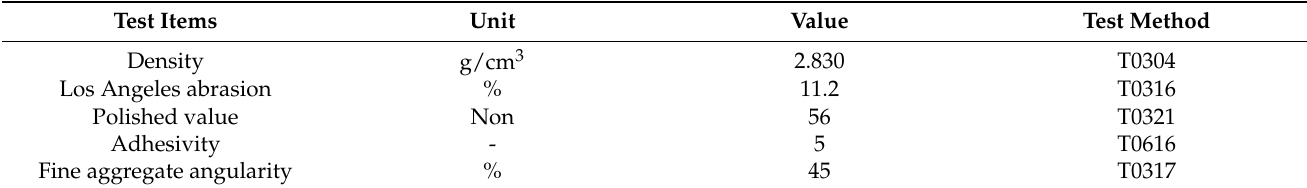
Table 2. Technical properties of aggregate.